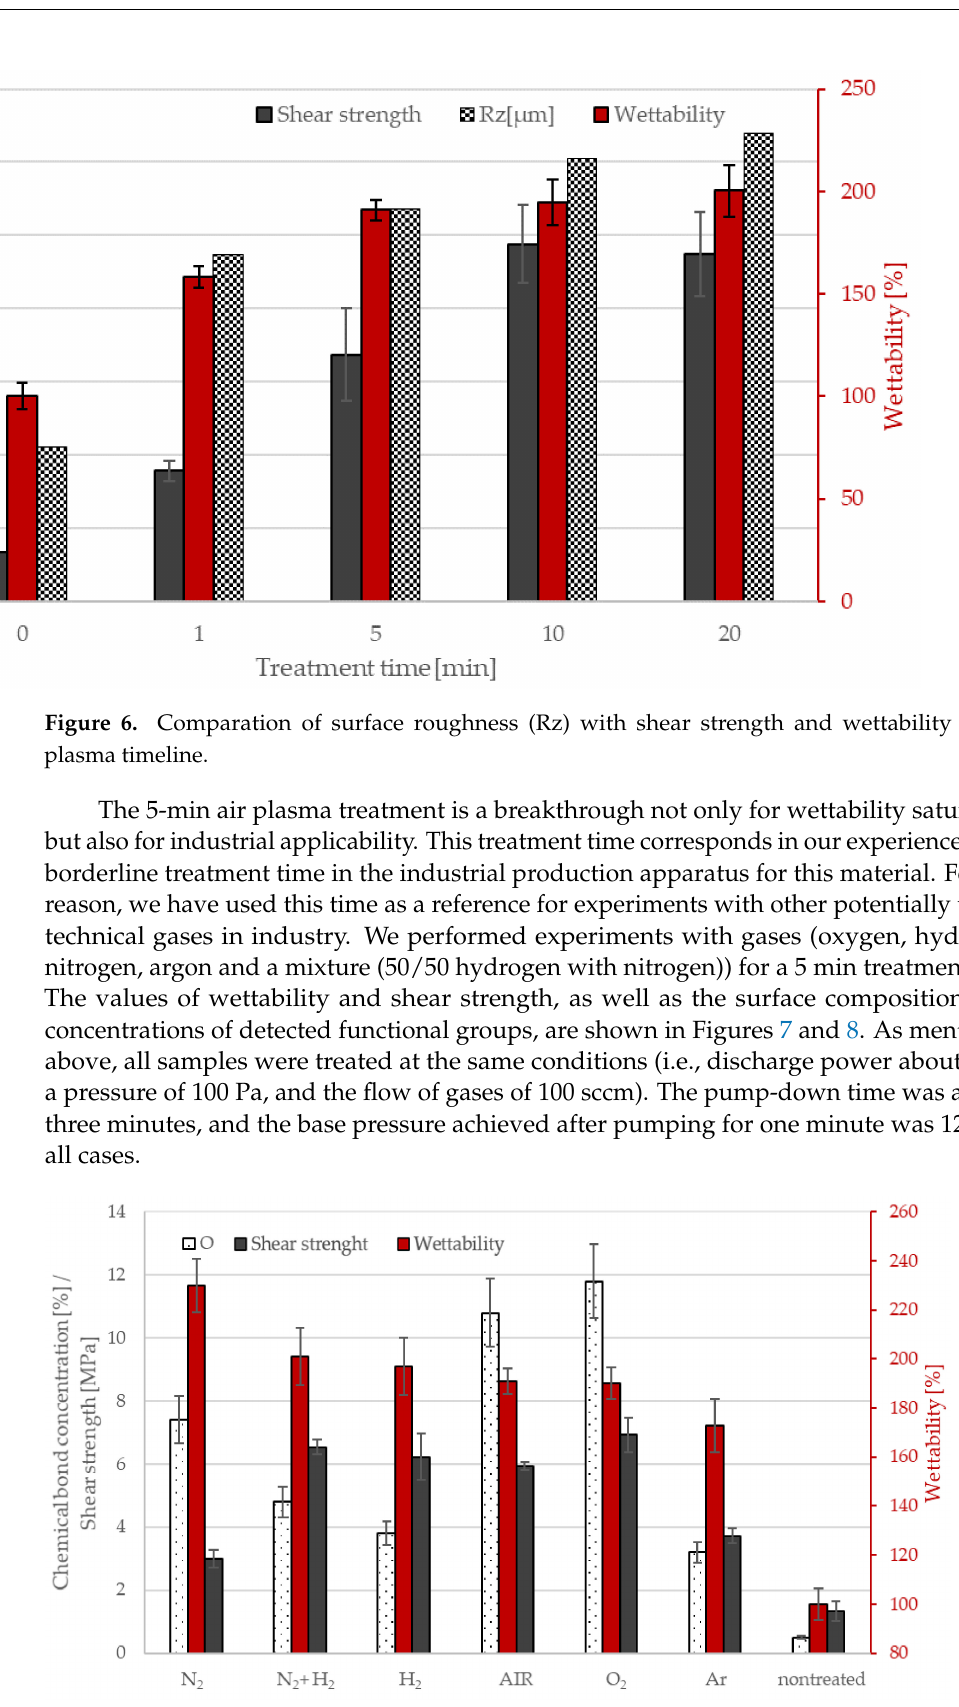
Figure 7. The composition of the surface film as deduced from XPS survey spectra for oxygen; wettability and shear strength in dependence on working